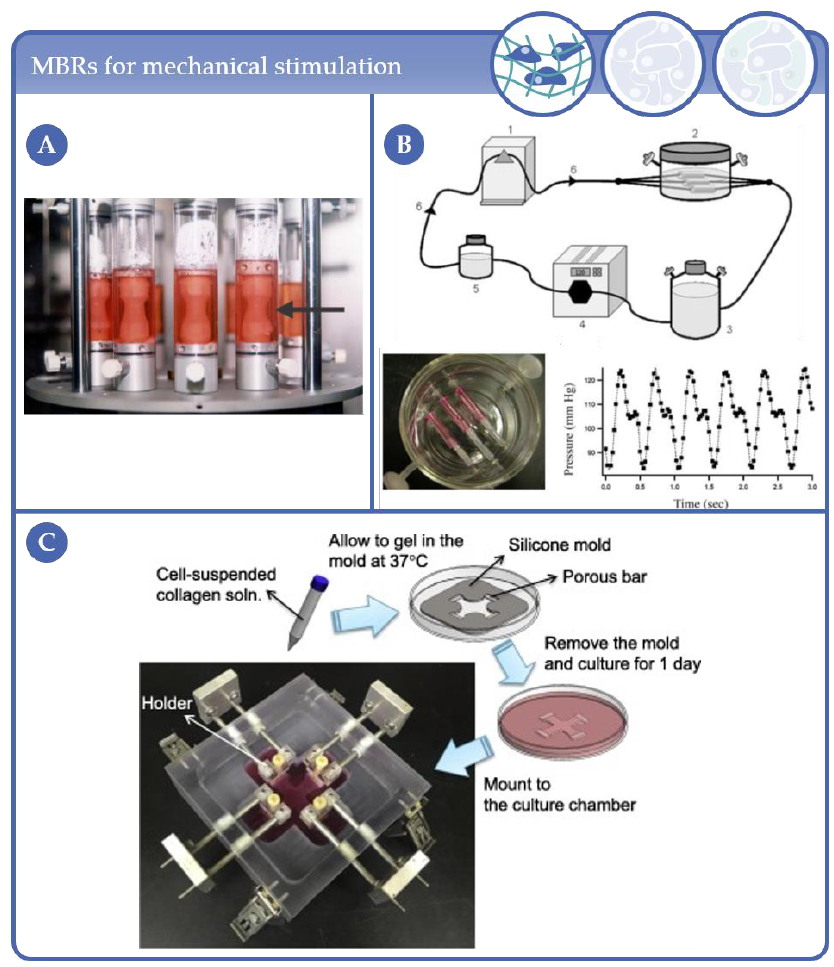
Figure 2. Examples of MBRs for mechanical stimulation established for ( A ) the application of ligament-like multidimen- sional mechanical strains; the arrow indicates a collagen gel suspended between two bone anchors as it is stimulated translationally and torsionally. Reprinted from [6] with permission of John Wiley and Sons. ( B ) The application of physi- ological shear and pulsatile conditioning of vascular in vitro-constructs in a pulsatile flow bioreactor; a schematic of the system design, which includes (1) one or more pulsatile pumps, (2) custom graft chamber, (3) media reservoir, (4) a peri- staltic pump, (5) compliance chamber, (6) check valves; close up of the graft chamber and representative pressure wave- forms. Reprinted with permission from [8]. ( C ) Application of biaxial stretch to fibroblast-seeded cruciform shaped gels. Reprinted from [11] with permission of Elsevier.